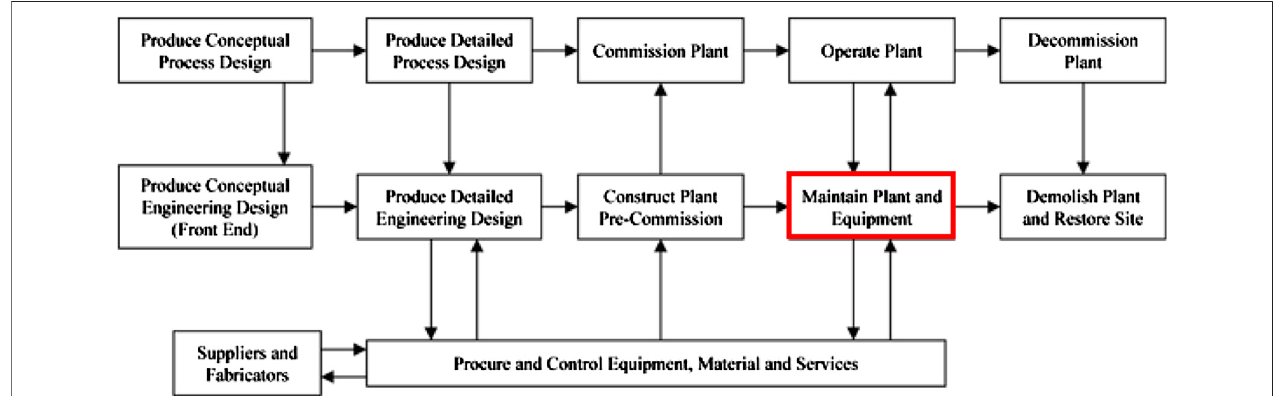
FIGURE 1 | Main activities and data fl ows associated with the life-cycle of a plant, adapted from ISO 15926 – 1:2004 (en).